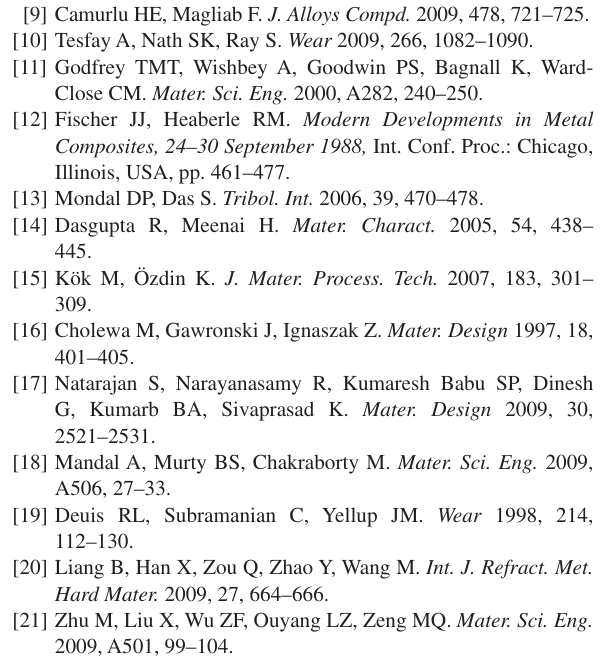
reinforced Al composite. 2